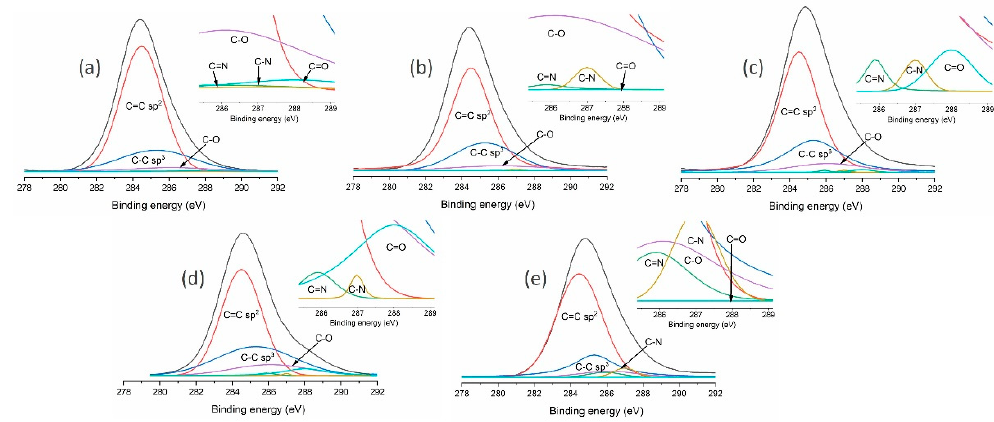
Figure 3. Analysis of C1 peaks obtained in X-ray photoelectron spectroscopy (XPS) studies of carbon flakes produced using ( a ) methane; ( b ) methane and hydrogen mixture; ( c ) methane and argon mixture; ( d ) methane and oxygen mixture; and ( e ) methane and nitrogen mixture.